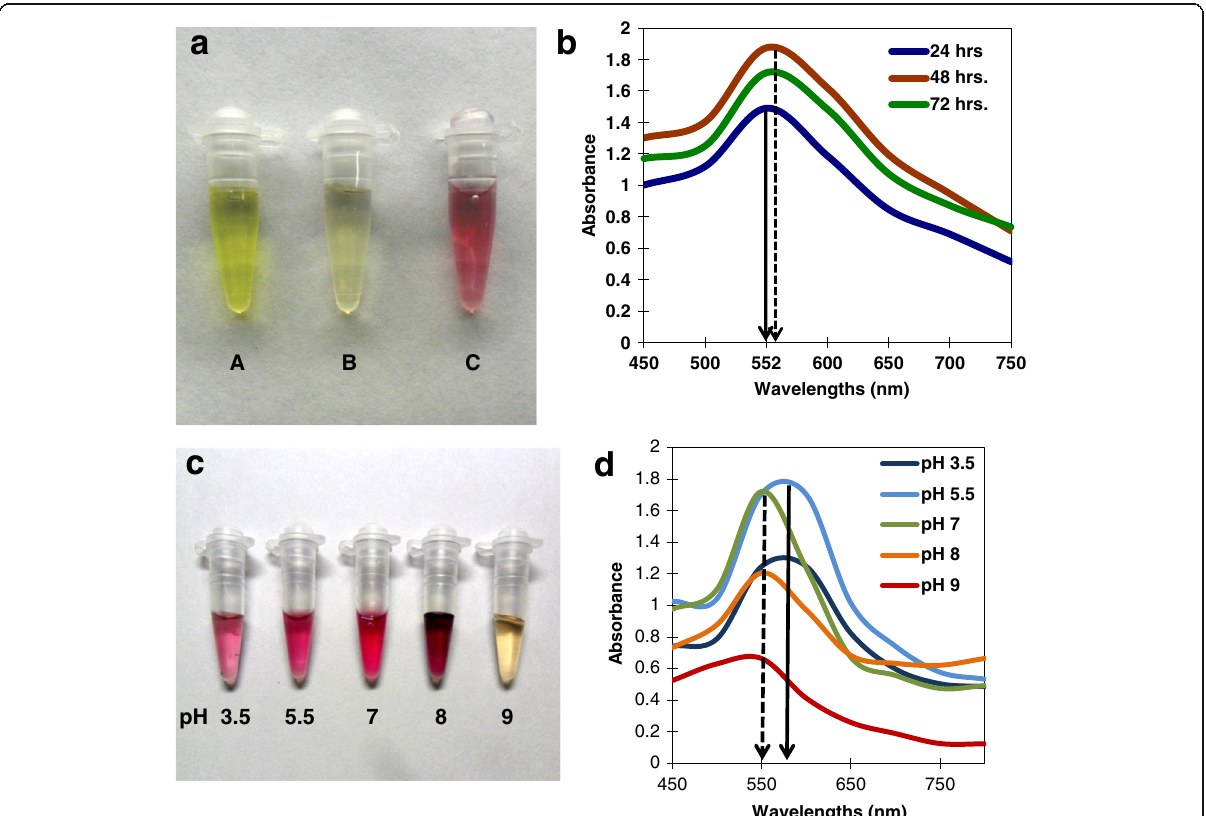
Fig. 1 Biosynthesis of AuNPs using Tricholoma crassum and spectroscopic analysis. a Color change during reaction. A 20 mM solution of HAuCl 4 . B Mycelia-free cell filtrate of Tricholoma crassum . C 1 mM HAuCl 4 with 24 h cell filtrate for 1 h showing violet color indicating synthesis of AuNPs. b UV-vis spectra of the AuNPs synthesized with different incubation periods (24, 48, 72 h). Solid arrow shows absorption peak at 552 nm for 24 h incubation period. Dashed arrow shows slight red shift of the absorption maxima with increase in incubation period. c AuNPs synthesized under different pH showing different colors. d UV-vis spectra of the same. Solid arrow shows absorption peak at 552 nm for pH 5.5 and dashed arrow indicates blue shift of absorption maxima with increase in